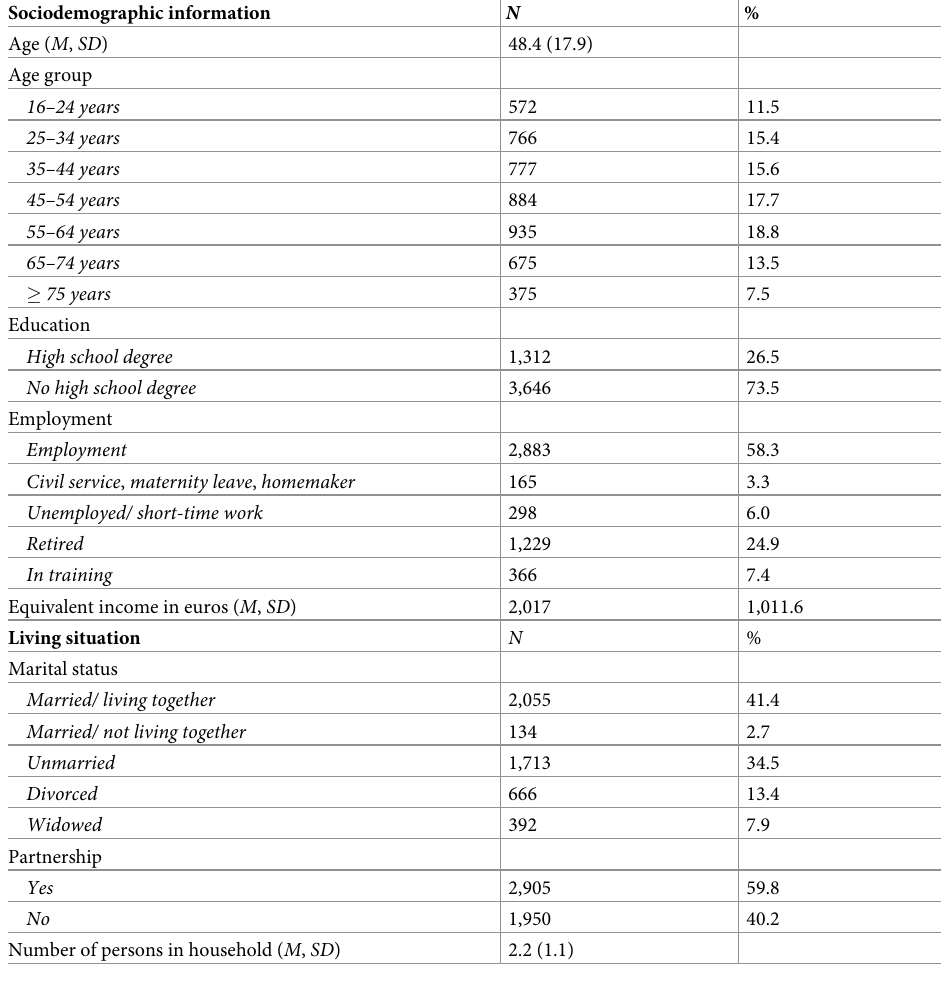
Table 1. Sample characteristics of the overall population (N total =